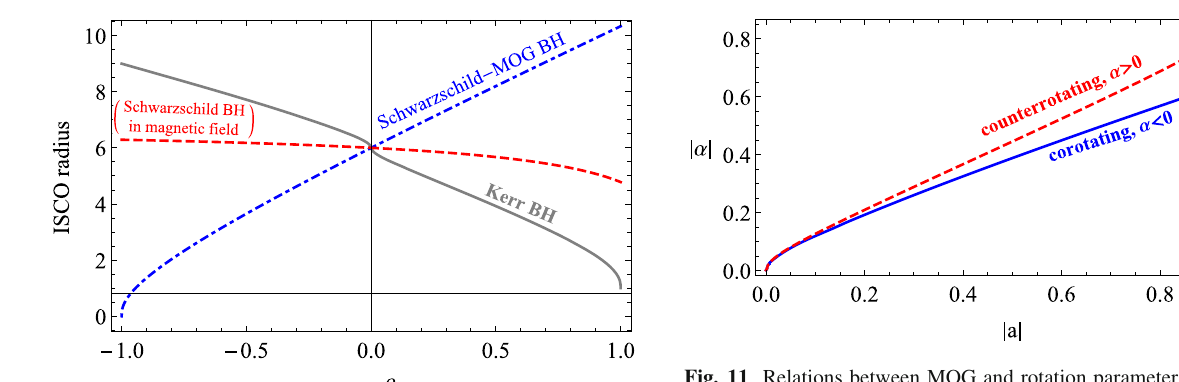
Fig. 9 The radial dependence of the center of mass energy of collision of different charged particles with the same initial energy E 1 = E 2 = 1, in the different values of the MOG parameter, α , considering head on collision with the specific angular momentum l 1 = 2 and l 2 = − 2. Top-